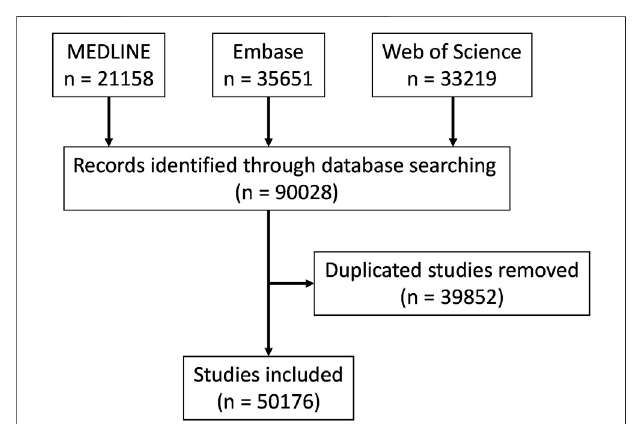
FIGURE 2 | Flow chart of study